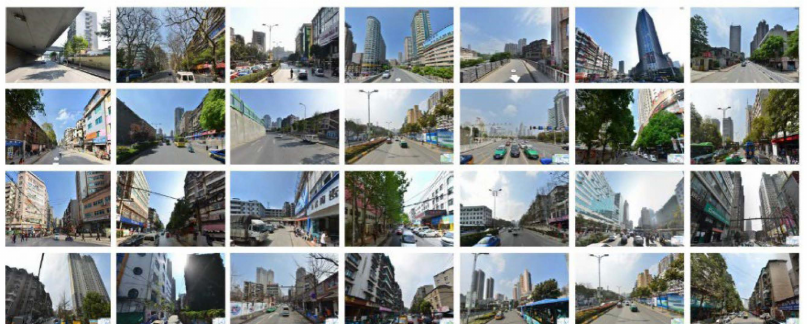
Figure 1. Tencent Streetview pictures of downtown Guiyang (selected).